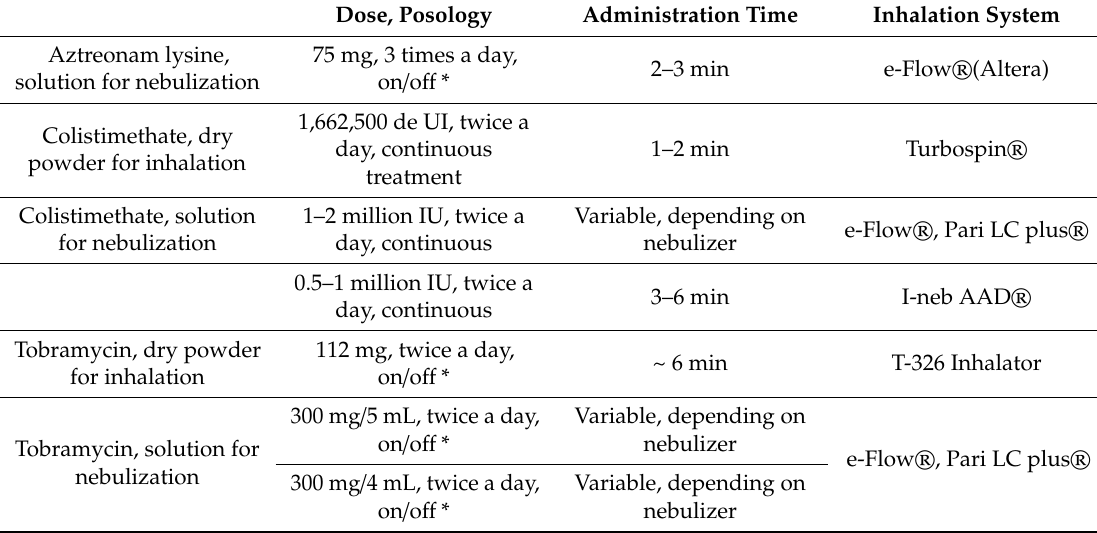
Table 6. Inhaled antibiotics marketed for administration by